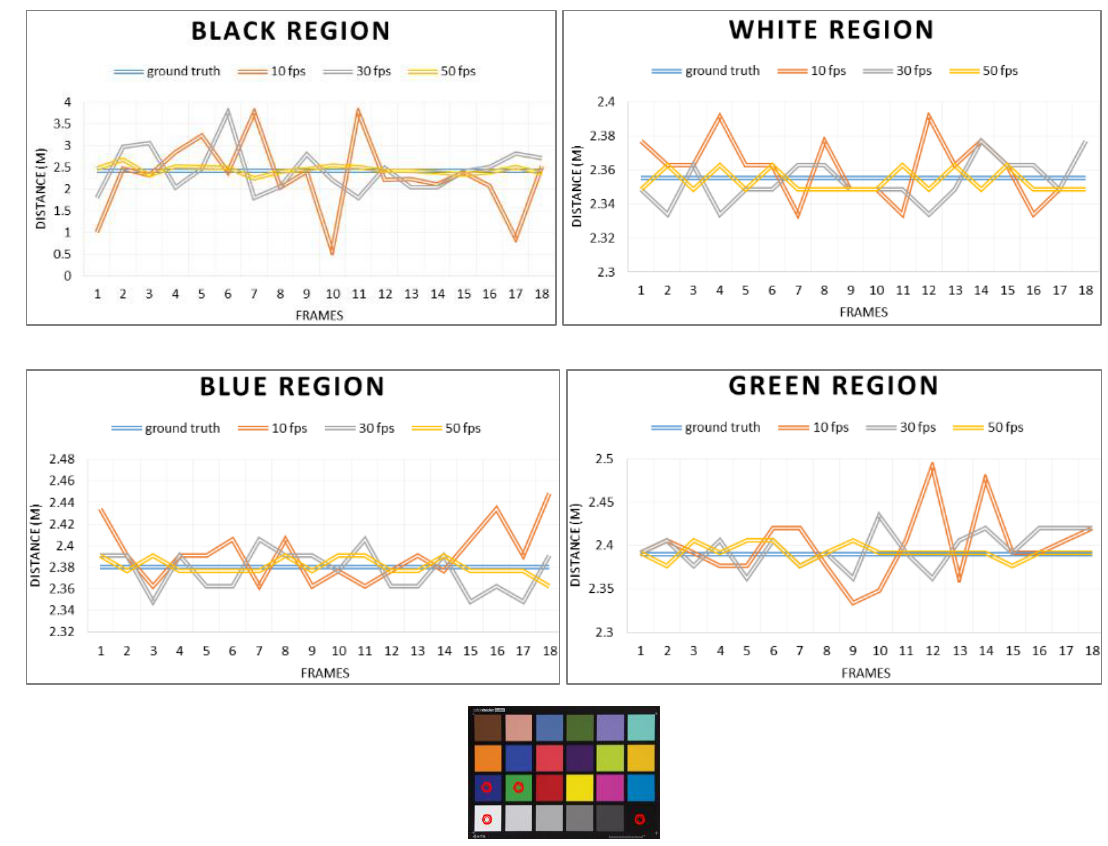
Figure 2. Depth information acquired in di ff erent colors at di ff erent integration times using the ToF depth camera.